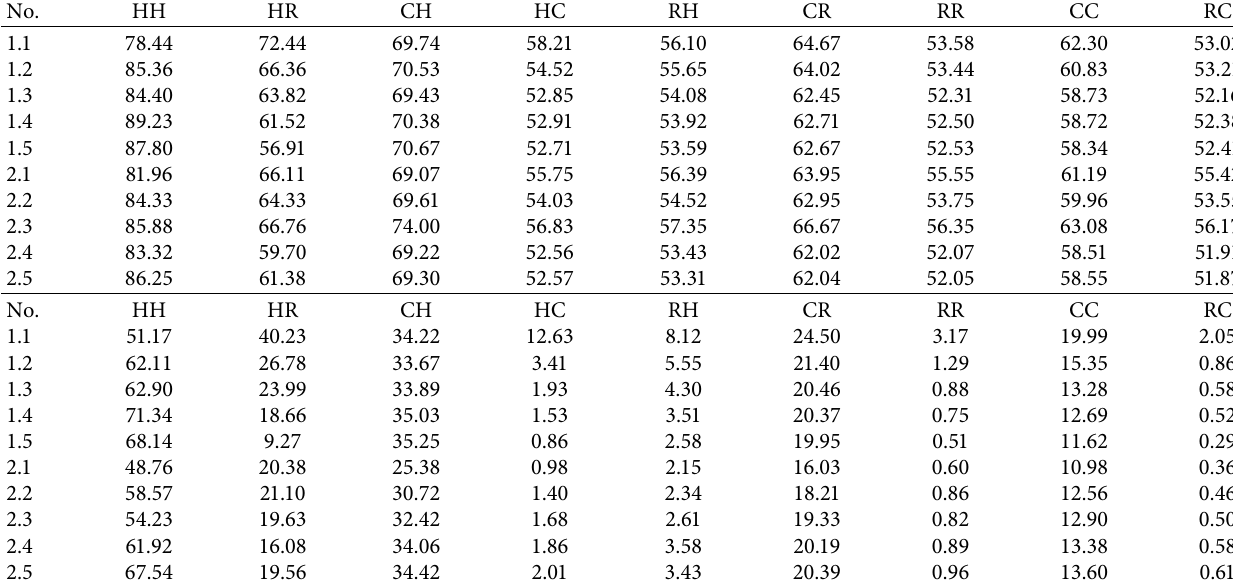
Table 13: Mean percentage qualities of the best-found schedules returned by the LS algorithms (the top table) and mean percentage improvements of the lengths of schedules returned by the LS phase with respect to the lengths of schedules returned by the initialization phase (the bottom table) for each of the ten classes of the benchmark given in [9] with cov � 100%.